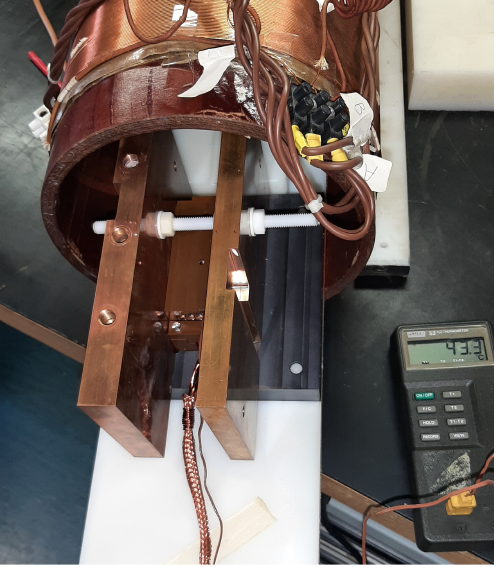
Figure 12. The operation of the sensing part was tested at an increasing temperature of up to 44 ◦ C, the temperature was stabilized by inserting the sensing part between a pair of thick copper blocks.